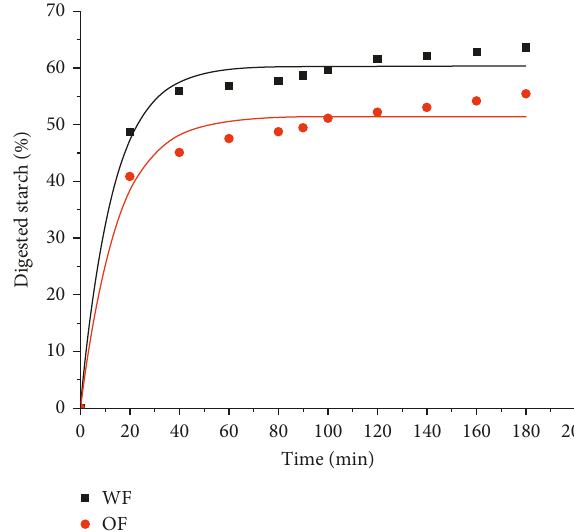
Figure 1: Hydrolysis curves of wheat flour and optimized flour. WF: wheat flour; OF: optimized